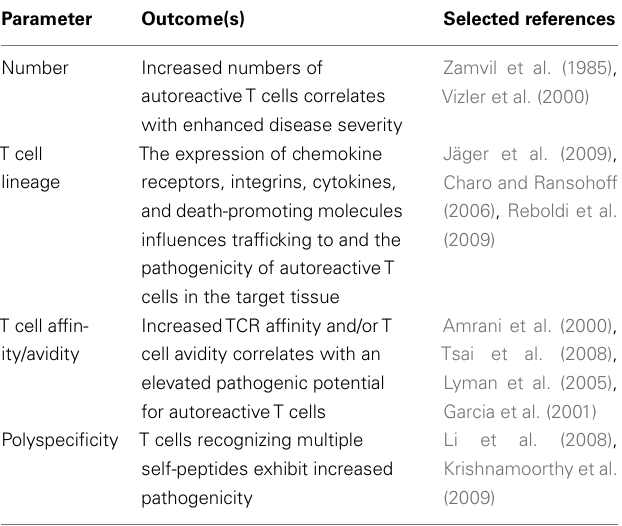
FIGURE 1 | Schematic representation of the possible structural bases underlying the dual specificity of 2D2T cells for MOG38–50 and NF-M18–30. The core region of the MOG38–50 peptide ranges from Y40 toV47 and contains the amino acids at position 41, 44, 46, and 47, which are known to be the contact amino acids for the 2D2-TCR and other MOG-specificT cell lines (Petersen et al., 2004; Ben-Nun et al., 2006).These amino acids are preserved at identical positions in NF-M18–30.The NF-M18–30 (TETRSSFSRVSGS) and the MOG38–50